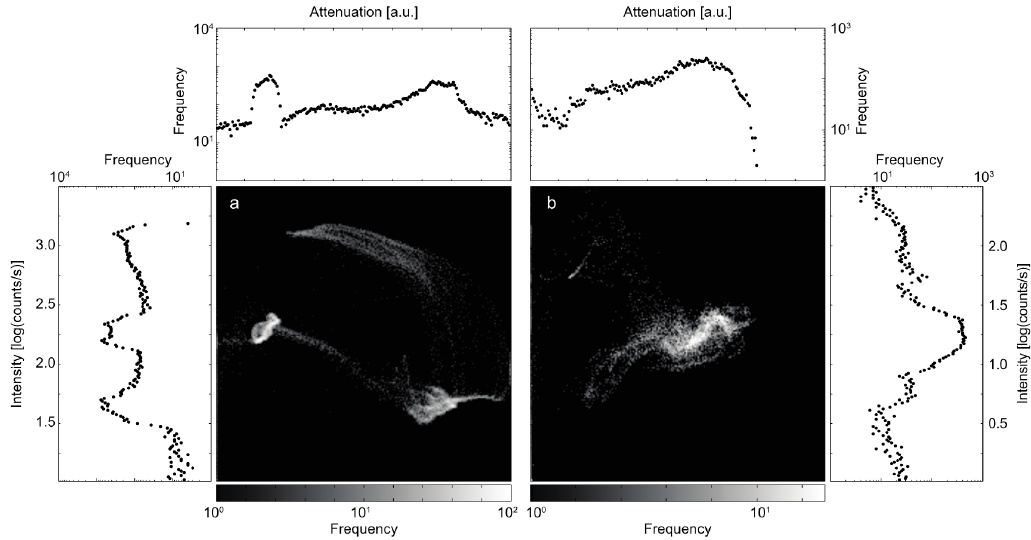
Figure 7. The bivariate histogram plots of the scattering signal (ordinate) and the integrated X-ray attenuation (abscissa) are displayed for the natural ( a ) and the artificial ( b ) lesions.